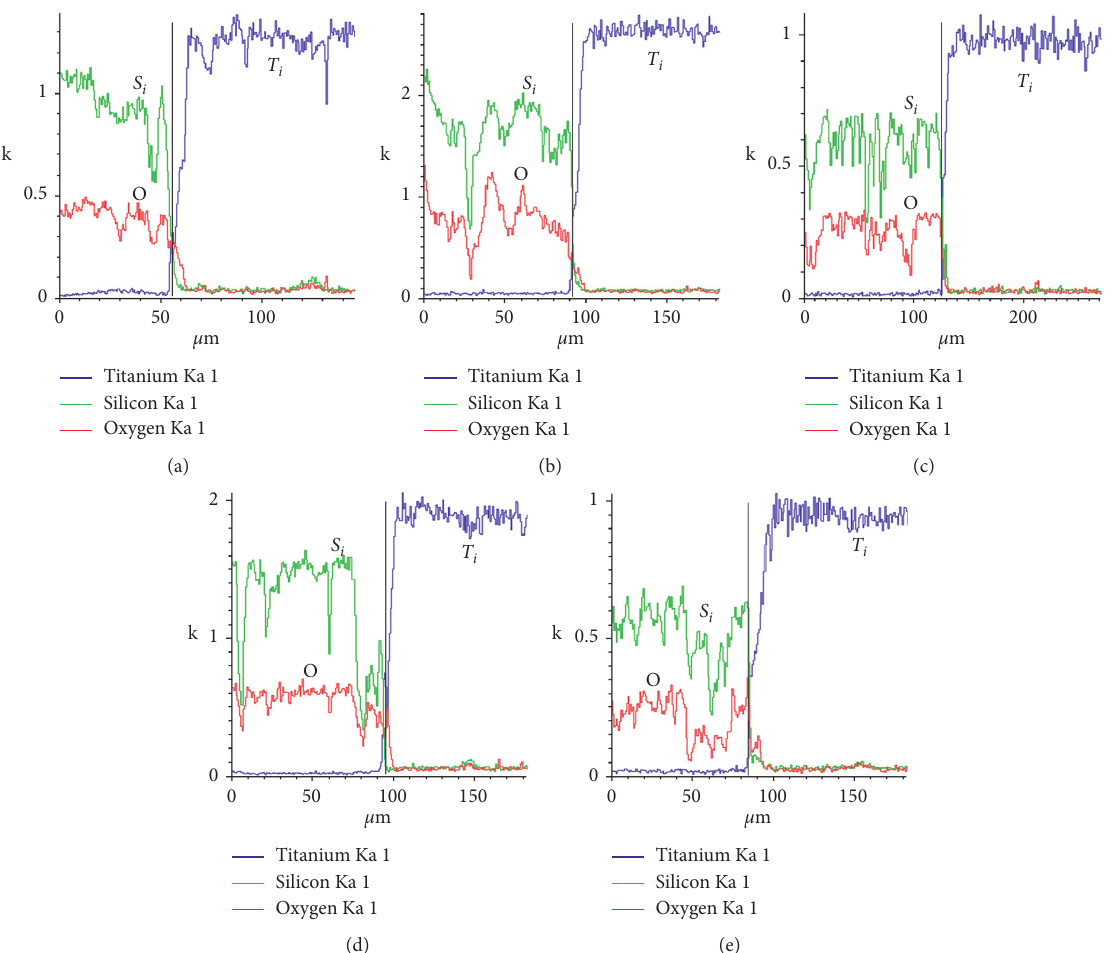
6 group, (c) 20g/L MgSiF 6 group,